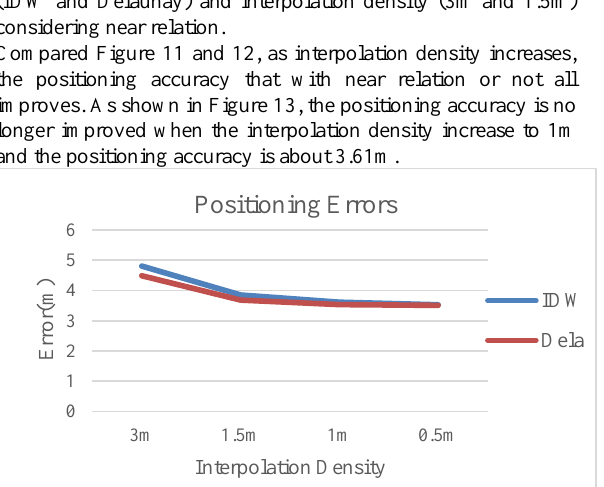
Figure 11. Positioning error with different interpolation methods (IDW and Delaunay) and interpolation density (3m and 1.5m) without near relation.